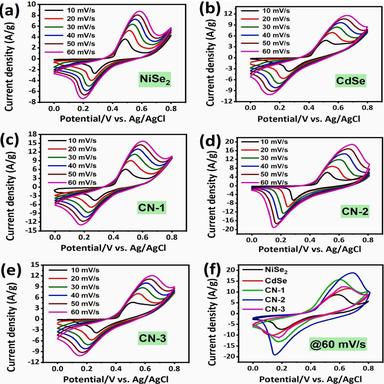
CV voltammogram of the electrodes, (a) NiSe2, (b) CdSe, (c) CN-1, (d) CN-2, (e) CN-3 composite, (f) comparison plot of all electrodes at fixed scan rate.